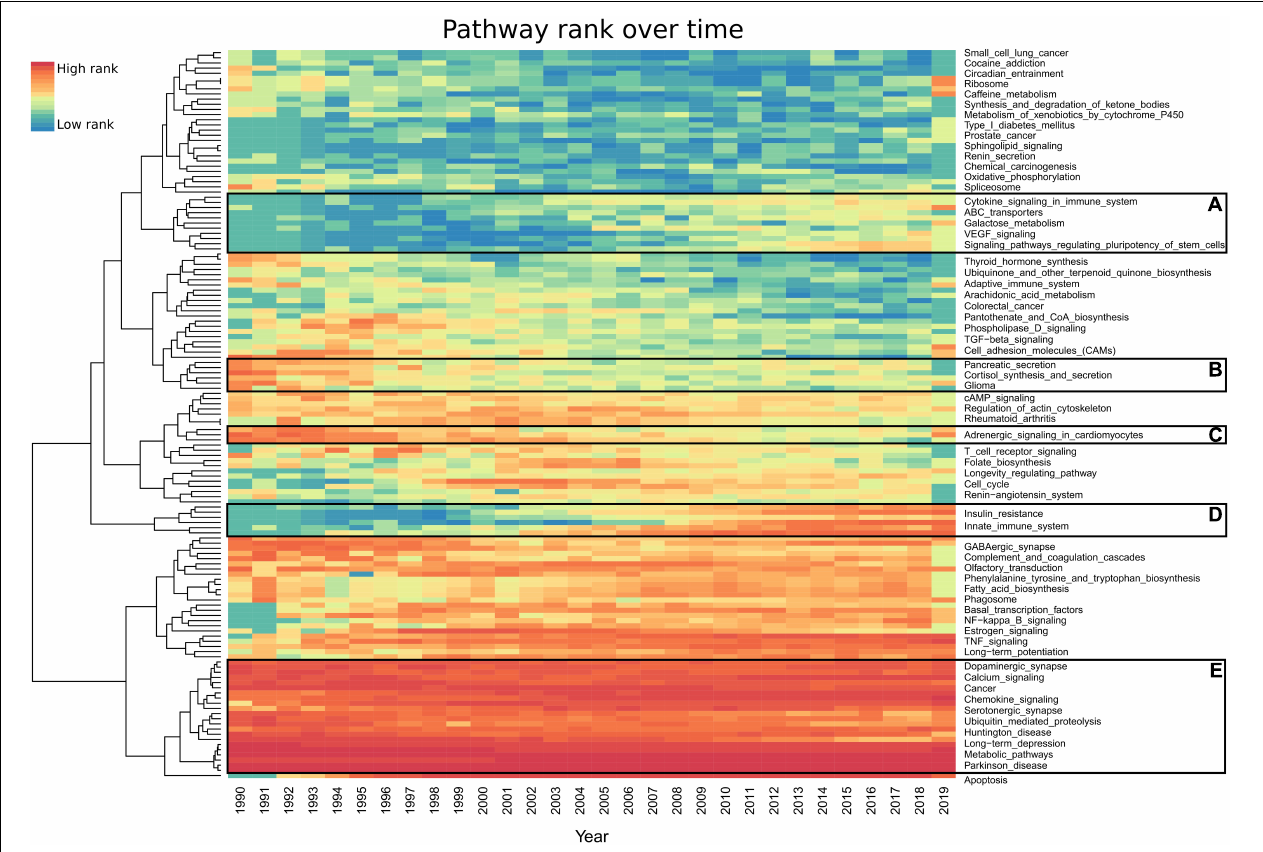
FIGURE 4 | Heatmap representing each pathway’s prevalence over the last 30 years. Each year’s highest ranked pathways are denoted in red, while the lowest rank is denoted in blue. For an improved visualization, we excluded 142 pathways having less than 20 studies per year. AMiner was updated in 2019 so it only captures part of that year. (A,D) Pathways which gained interest. (B,C) Pathways which have lost interest since the 1990s. (E) Pathways which have been consistent in their high scores every year since 1990. Full results can be found in Supplementary Table 6